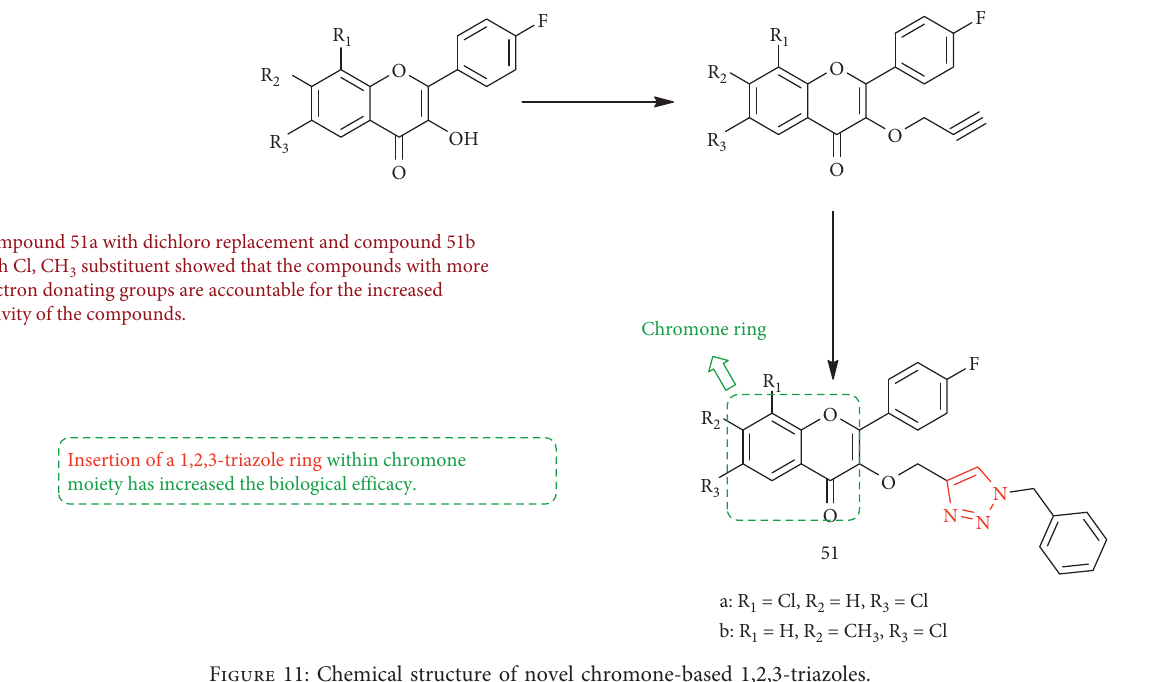
Figure 11: Chemical structure of novel chromone-based 1,2,3-triazoles.